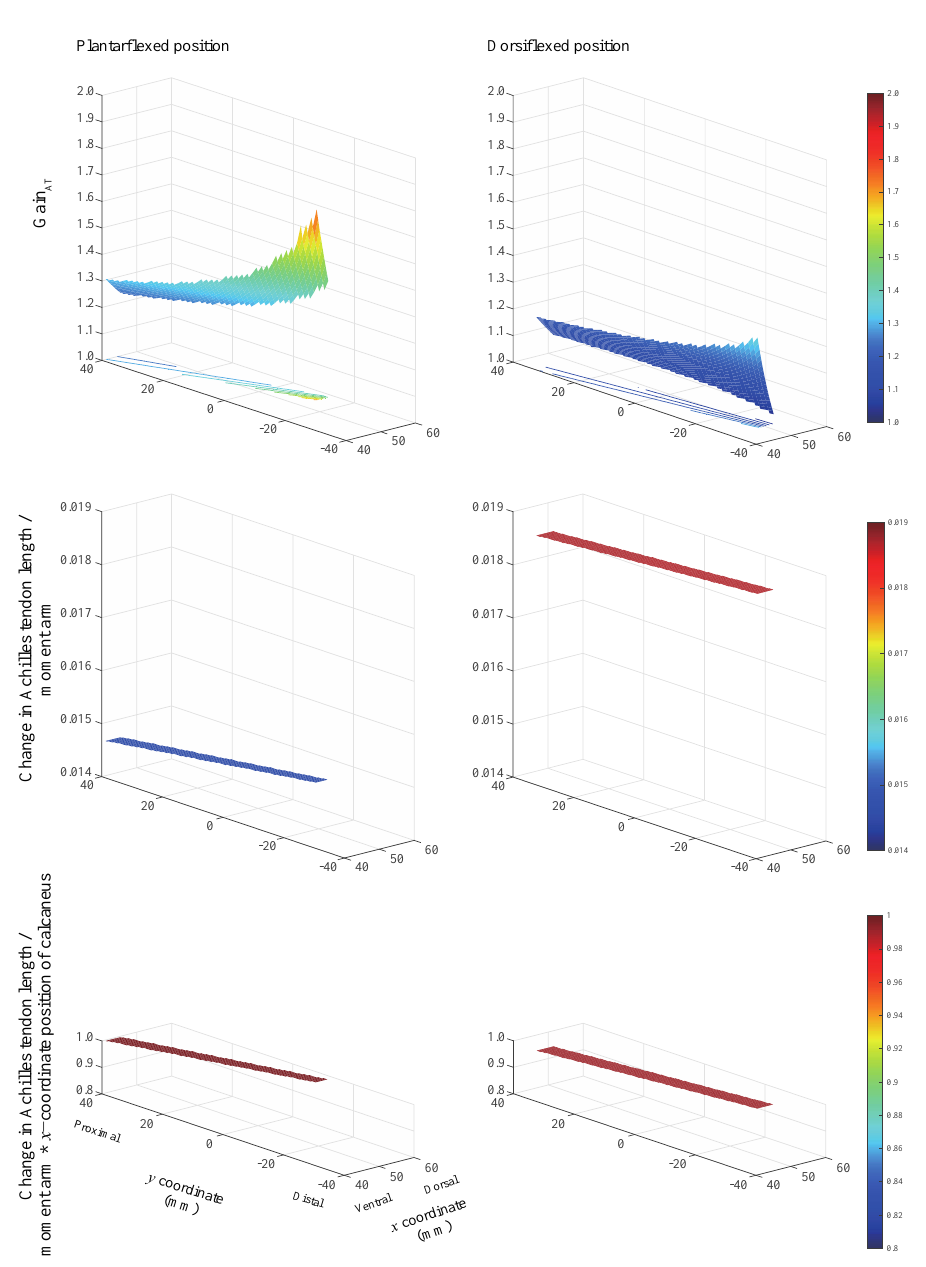
Figure 3. Effects of inflection point locations and ankle positions on gain AT ( top ), ratio of change in the Achilles tendon length to moment arm ( middle ), and product of the ratio of change in the Achilles tendon length to moment arm and the x -coordinate of calcaneus position ( bottom ), for 1 mm calcaneus displacement. We used a model where the position of the inflection point is varied, whereas the displacements of the myotendinous junction with respect to the calcaneus remains constant. Three-dimensional surface plots showing the change in the Achilles tendon length (Z axis) with respect to the location of the inflection point along the x (X axis) and y (Y axis) directions. This change is shown for two ankle positions: plantarflexed ( left ) and dorsiflexed ( right ) positions.